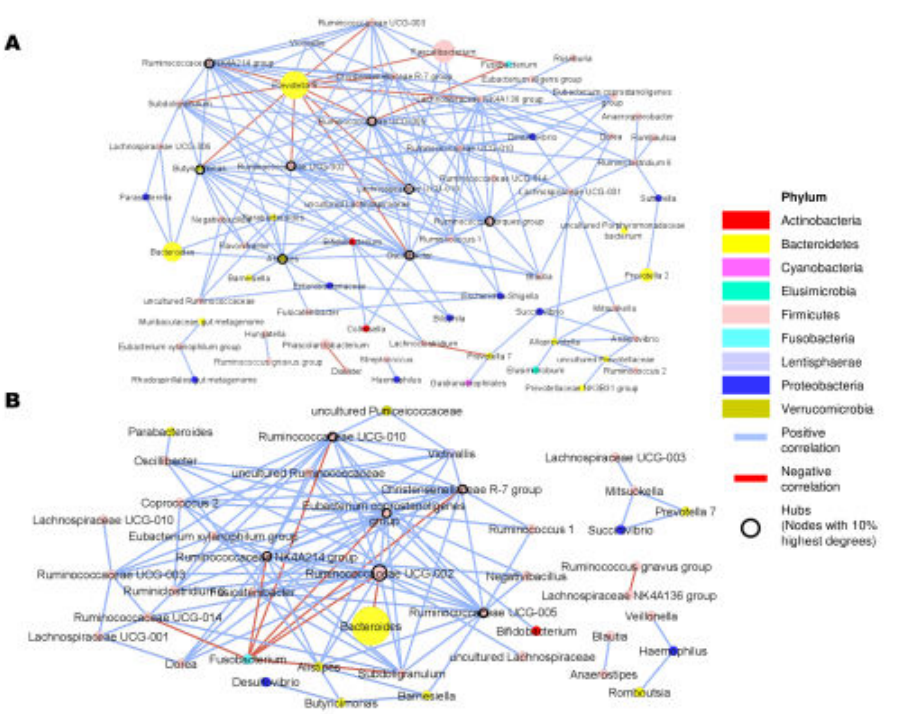
Figure 4. Co-occurrence network. Co-occurrence network of EnP (A) and EnB (B) were con- structed based on Spearman’s correlation between microbial profiles with the criteria | ρ | ≥ 0.5 and p -value < 0.05. Nodes and edges represent taxa and microbe–microbe relationships, and node and edge colors denote bacterial phylum and type of correlation,